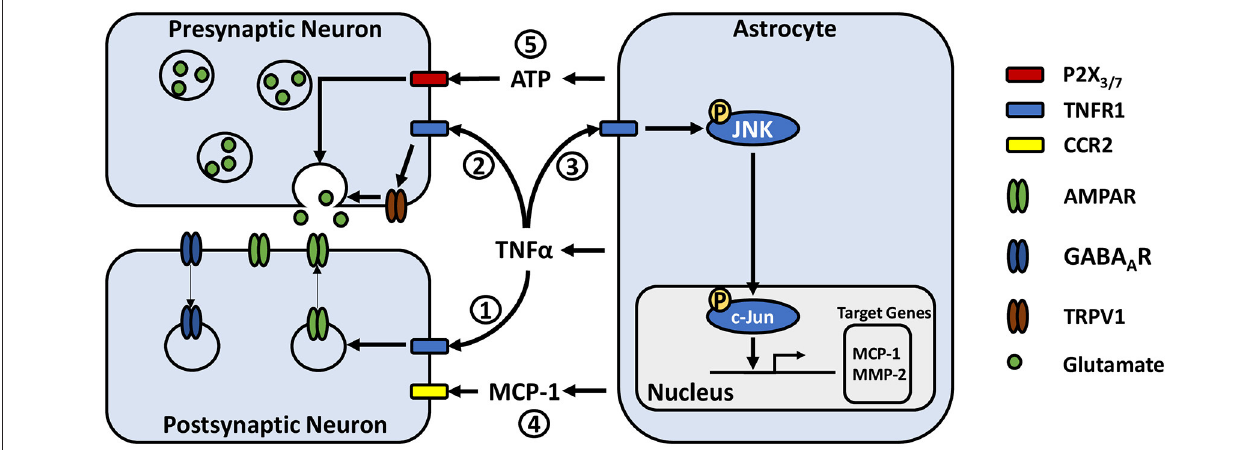
FIGURE 1 | Potential astrocyte-neuron signaling pathways in modulating pain-related synaptic transmission. (1) TNF α acts on neuronal TNFR1 resulting in rapid trafficking of GluR2-lacking AMPA receptors to the postsynaptic membrane and internalization of postsynaptic GABA A receptors. (2) TNF α increases presynaptic glutamate release, potentially by activating or increasing the expression of transient receptor potential subtype V1. (3) TNF α acts on astrocytic TNFR1, inducing phosphorylation of JNK. JNK phosphorylates c-Jun, which dimerizes with c-Fos to form the AP-1 transcription factor, leading to transcription of target genes such as MCP-1 and MMP-2. (4) MCP-1 is released from astrocytes where it can act on neurons via CCR2, modulating their excitability. (5) ATP released from astrocytes may act on pre-synaptic neuronal P2X 3 and P2X 7 receptors, stimulating glutamate